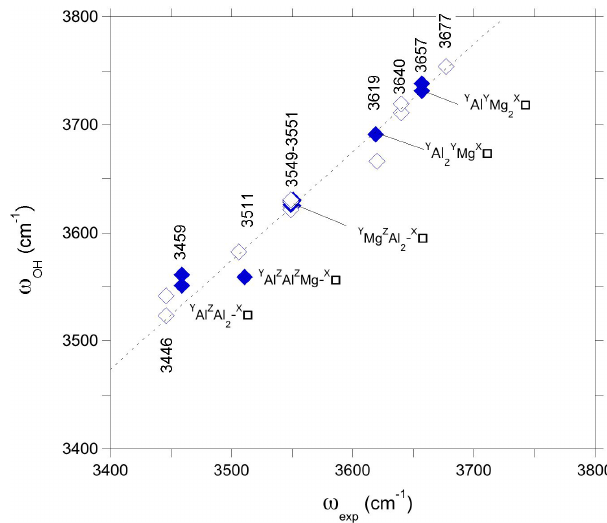
Figure 6. Theoretical OH stretching frequencies of models with vacant X sites obtained using the simple hexagonal cell (Table 1) (full symbols) reported as a function of the experimental ( ω exp ) OH stretching frequencies of the Mg-foitite MF2 sample of Berryman et al. (2016). For comparison with Fig. 5, the theoretical frequen- cies obtained for the larger 1 × 1 × 2 supercell (corresponding to a more dilute vacancy concentration) are reported as a function of the experimental frequencies of dravite (open symbols). The dotted line corresponds to the equation ω OH = ω exp + 75cm − 1